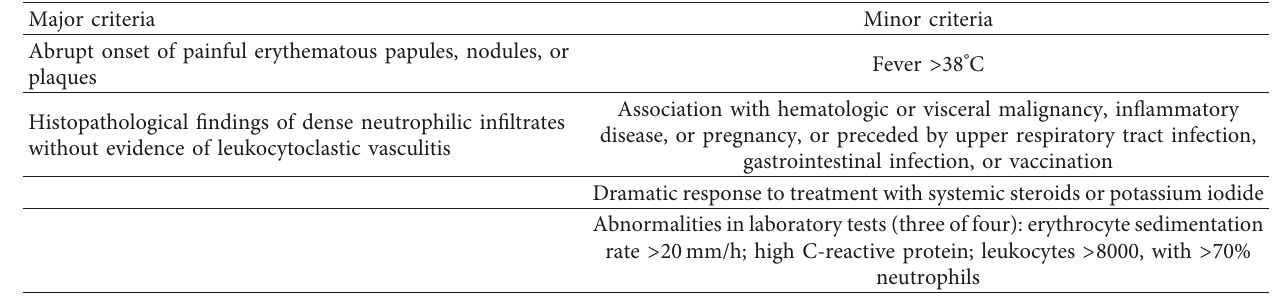
Table 2: Diagnostic criteria for Sweet’s syndrome.